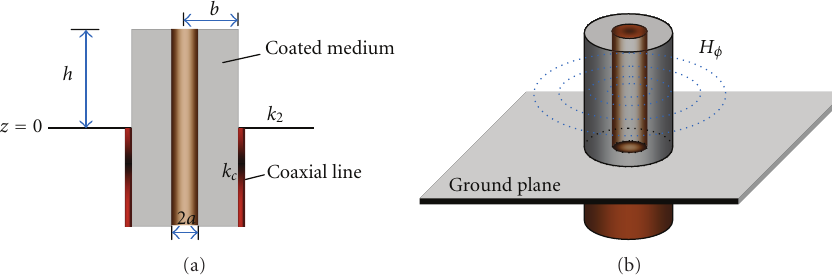
Figure 12: (a) Two-dimensional and (b) three-dimensional configurations of a coated monopole.